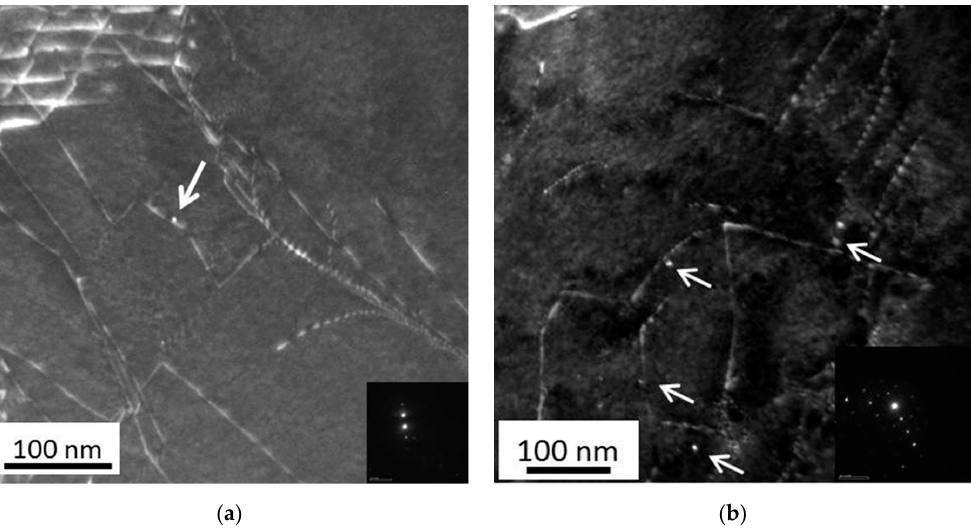
Figure 2. WBDF TEM image for the RPV base material, ( a ) high-flux condition (BH), ( b ) low-flux condition (BL). g = 110. Features identified as dislocation loops are marked with an arrow.